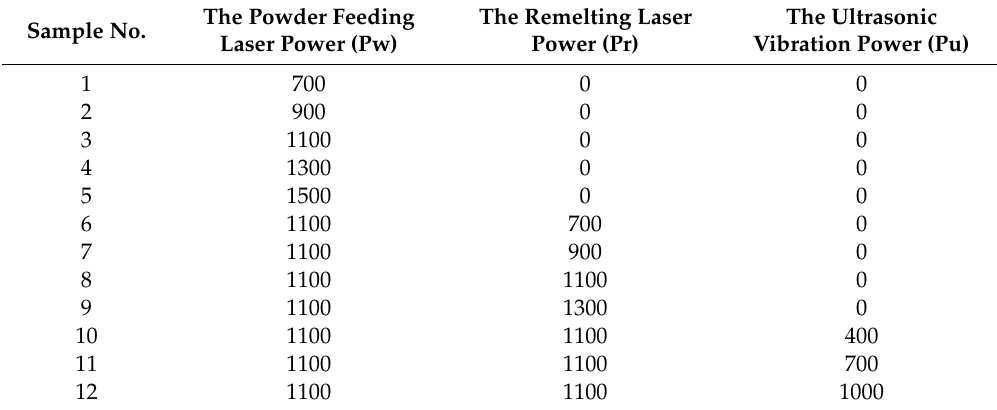
Table 1. Varied process parameters